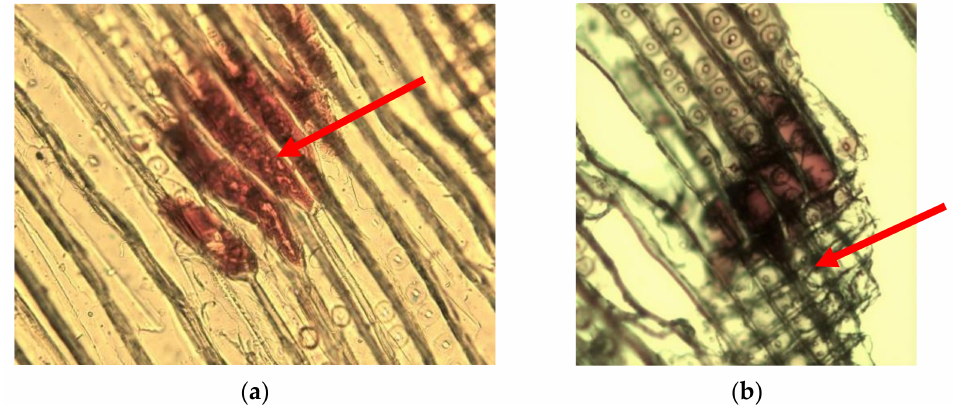
Figure 2. ( a ) Spruce ( Picea abies ) with 5% tannin solution 400 × . Tannin solution accumulated at the ends of tracheids; ( b ) Tannin solution does not enter in rays (radial parenchyma cells,